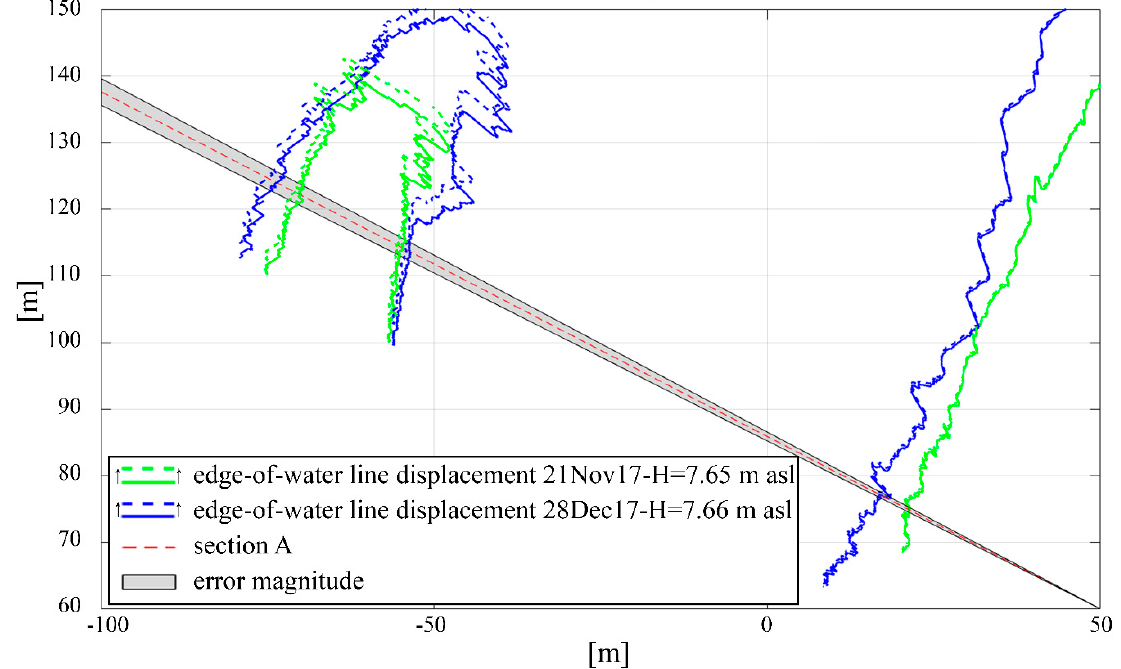
Figure 11. Variation of the error magnitude along the section A and the estimated deviations between positions of actual and projected edge-of-water lines.